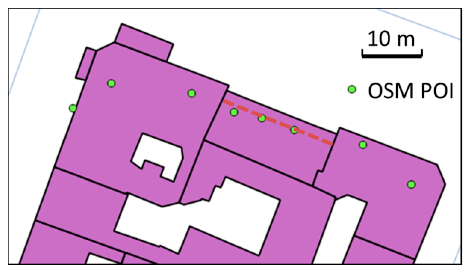
Figure 6. Even if there is no unique location for an amenity POI inside a building, consistency in POI location (here points should all be aligned) is better than inconsistency (©OpenStreetMap contributors).